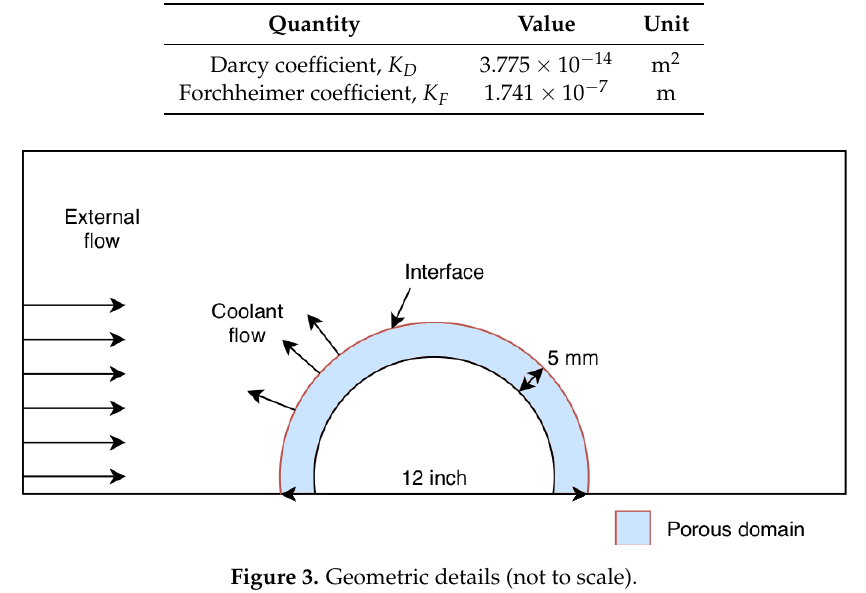
Table 2. Ultra high temperature ceramic (UHTC) material properties for UHTC-8 [13].